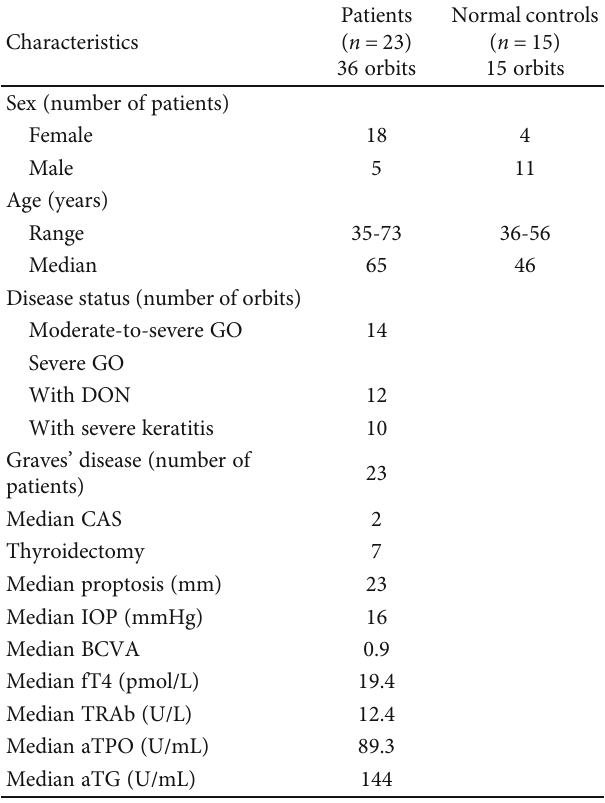
Table 1: Clinical characterization of the Graves ’ ophthalmopathy (GO) patients included in this study at the day of